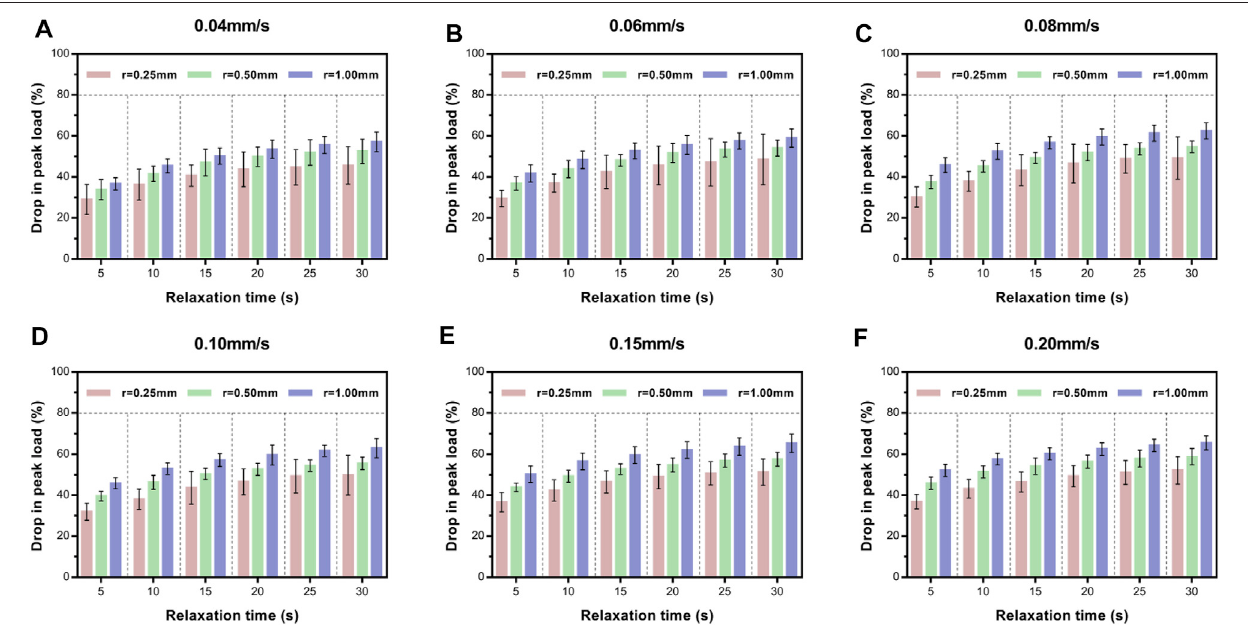
FIGURE 6 | Average relative drop compared with peak load for ex vivo specimens at six time points of load – relaxation tests at 0.04 mm/s (A) , 0.06 mm/s (B) , 0.08 mm/s (C) , 0.10 m/s (D) , 0.15 m/s (E) , and 0.20 mm/s (F) . Error bars are standard deviation. For multi-comparison tests, see Supplementary Table S4 .